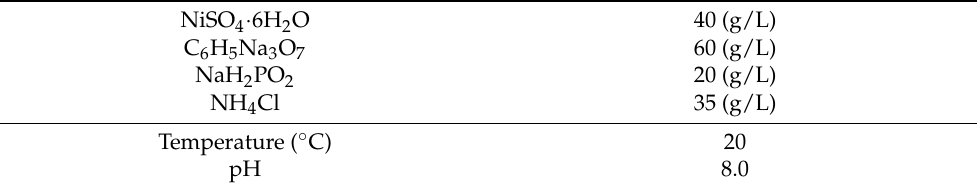
Table 1. Formula and conditions for electroless Ni plating.